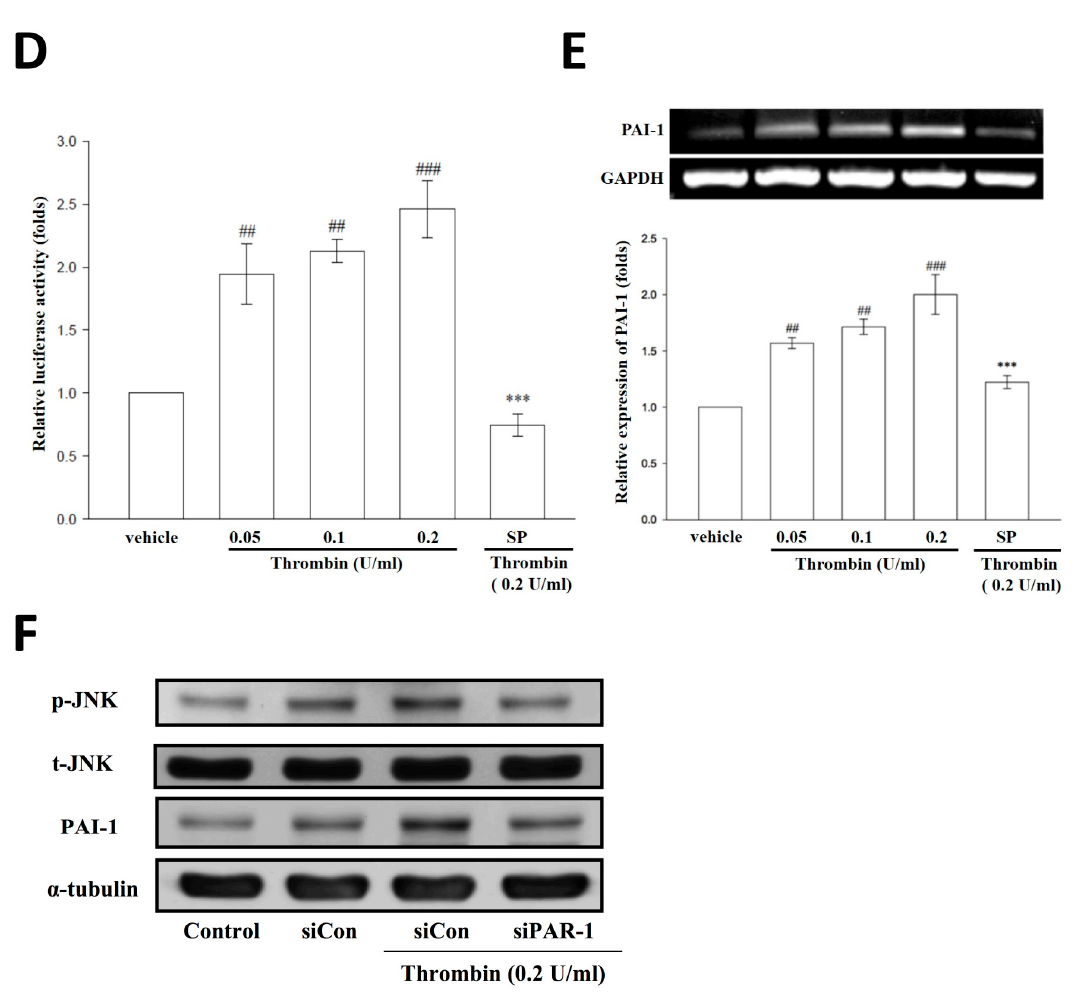
Figure 5. Thrombin induces PAI-1 expression in human PMCs through PAR-1 / JNK signaling. ( A ) Treatment with thrombin (0.01, 0.02, 0.05, 0.1, and 0.2 U / mL) for 24 h triggered PAI-1 expression in both MeT-5A cells and primary human pleural mesothelial cells (HPMCs). * p < 0.05, ** p < 0.01, *** p < 0.001 compared with vehicle group; ( B ) PAI-1 expression was determined by Western blotting assay in thrombin-stimulated MeT-5A cells pretreated with DMSO (dimethyl sulfoxide) or di ff erent signaling pathway inhibitors including parthenolide (Par, 10 µ M), LY294002 (LY, 20 µ M), PD98059 (PD, 20 µ M), SP600125 (SP, 10 µ M), and SB203580 (SB, 10 µ M). ### p < 0.001 compared with vehicle group, *** p < 0.001 compared with DMSO group; ( C ) The JNK phosphorylation was evaluated in MeT-5A cells treated with thrombin (0.2 U / mL) for the indicated times by Western blotting assay. # p < 0.05, ## p < 0.01, compared with resting group; ( D – E ) The reporter activity and mRNA level of PAI-I were assessed as described in “Methods and Materials” in thrombin (0.05, 0.1, 0.2 U / mL)-stimulated MeT-5A cells pretreated with